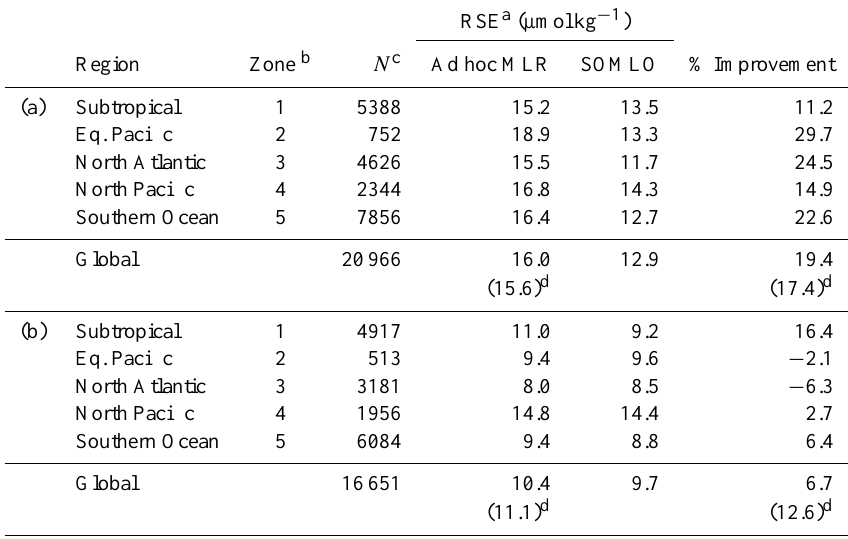
a Calculated using the SIT predictions. b Corresponding geographical region in Fig. 3. c Number of measurements. d Universal MLR.